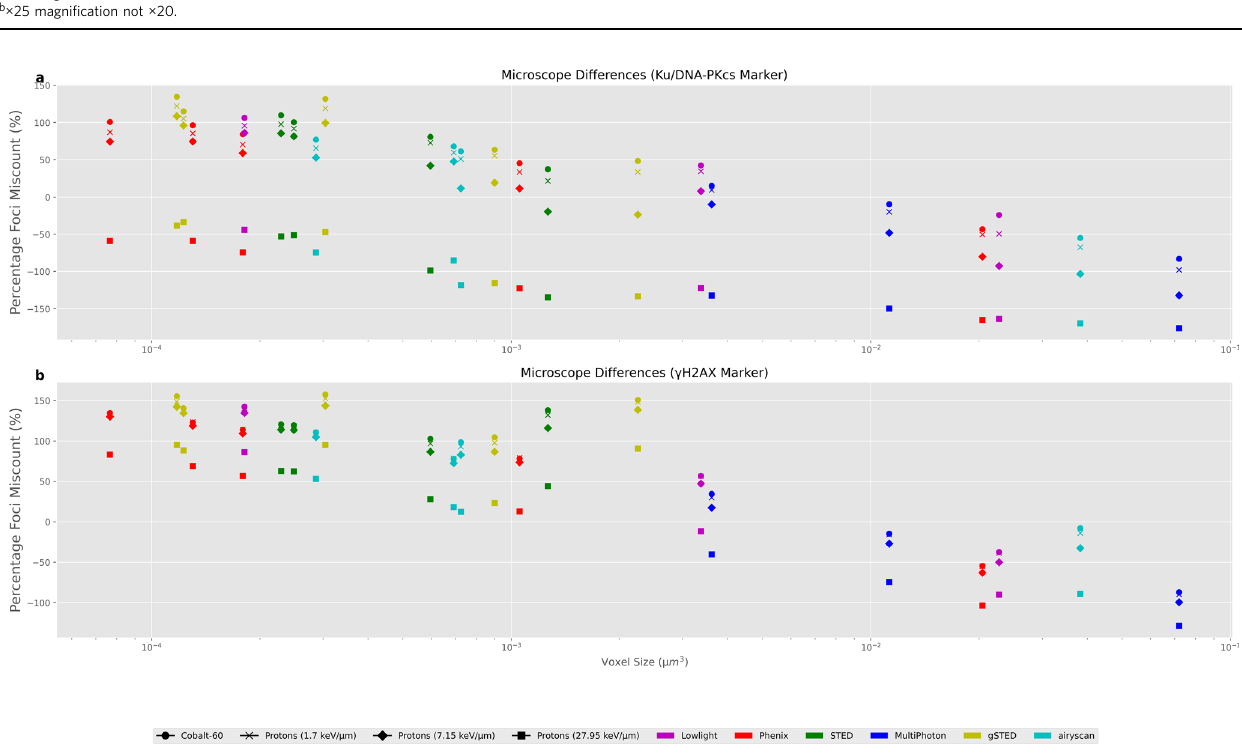
Along with the numerical aperture used when measuring the microscope PSF. Values given for all size microscopes at their respective magni fi cations. The STED microscope also has a PSF at ×25 which has the following values (0.06, 0.25, 0.95) for XY pixel spacing, Z pixel spacing and numerical aperture respectively.